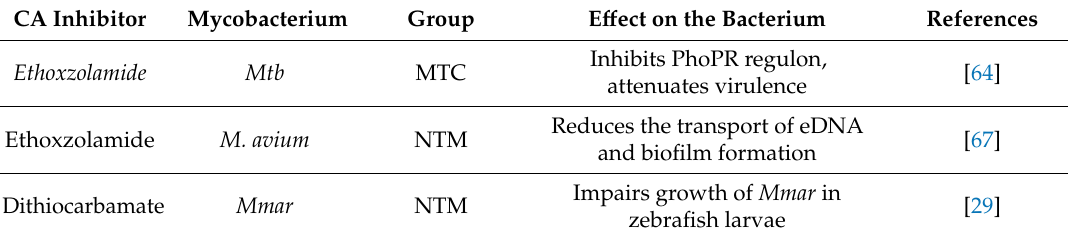
Table 2. In vivo inhibition studies showing the e ff ects of CA